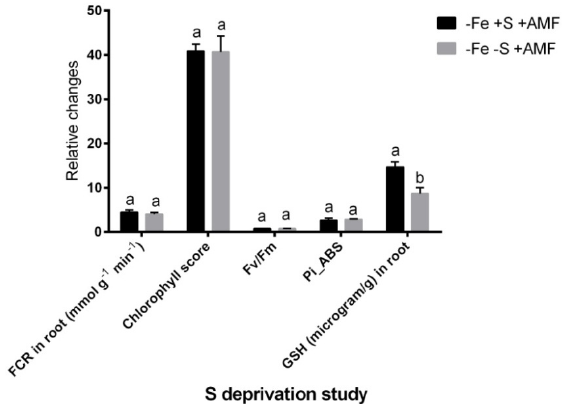
Figure 7. Sulfur deprivation study in alfalfa. Physiological and biochemical changes under Fe deficiency ( − Fe) in the presence or absence of sulfur ( +/ − S) and AMF. In the figure, FCR, Fv / Fm, Pi_ABS, and GSH indicate the ferric chelate reductase, quantum e ffi ciency of photosystem II, photosynthesis performance index, and glutathione accumulation with or without S supplementation in alfalfa, respectively. Data represent means ± SD ( n = 3). Different letters above the error bar indicate significant difference at p < 0.05 level.